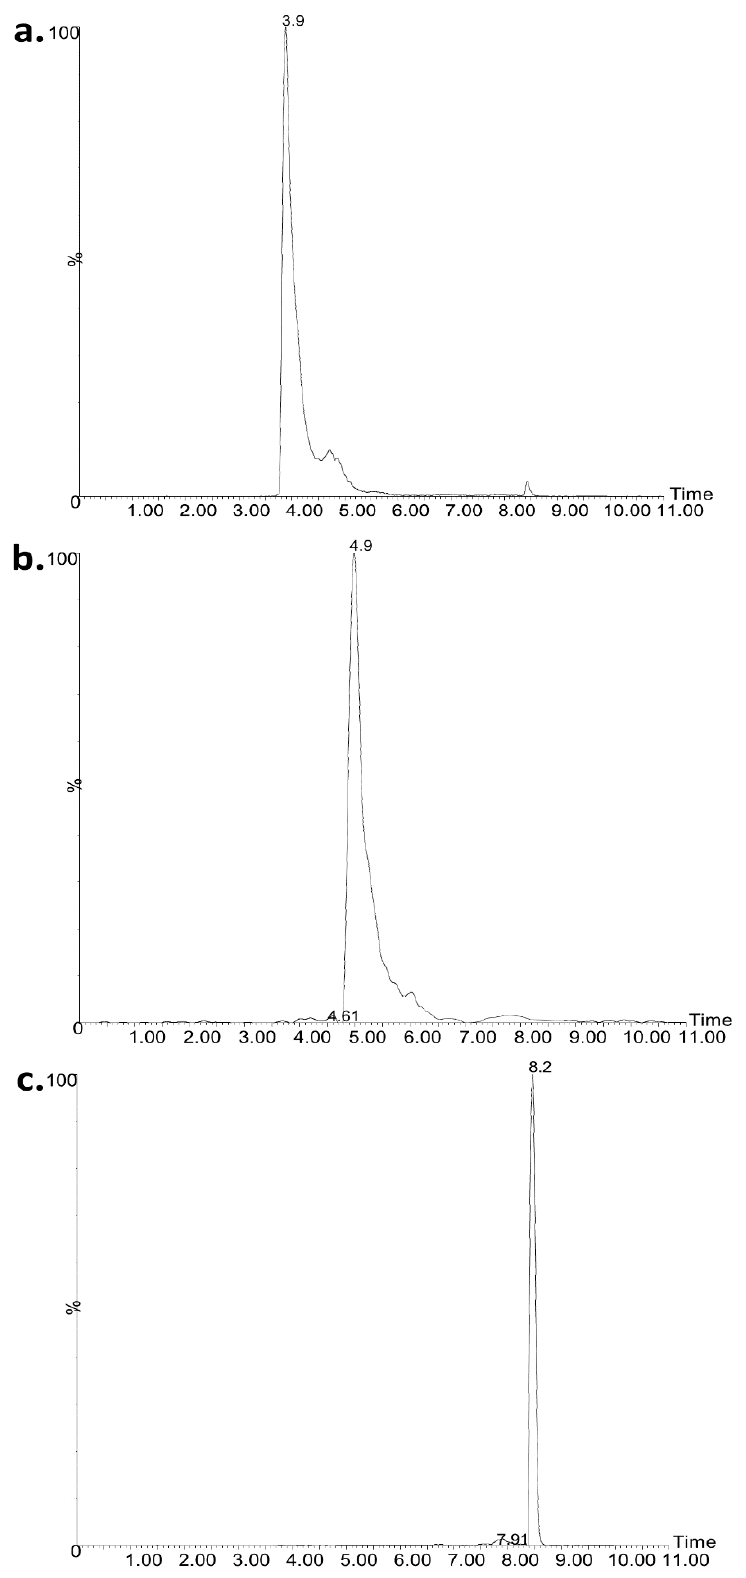
Figure 1. Representative ultra-performance liquid chromatography coupled to mass spectrometry (UPLC–MS) chromatogram of ( a ) CSB at 3.9 min, ( b ) CSA at 4.9 min, and ( c ) CMS at 8.2 min at concentration of 15.378, 6.622, and 22.0 µ g mL − 1 , respectively. CS, colistin; CMS, colistimethate